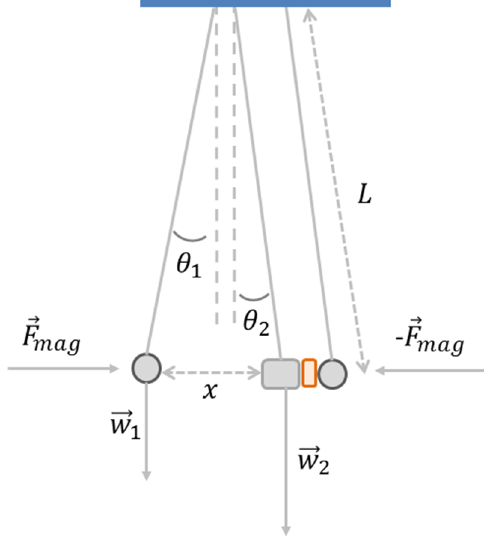
Fig. 10. Sketch of the Gauss pendulum indicating relevant parameters for the Scilab model